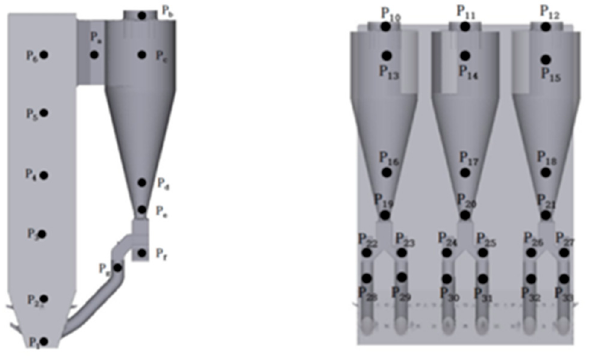
Figure 2. Distribution of pressure measurement points.